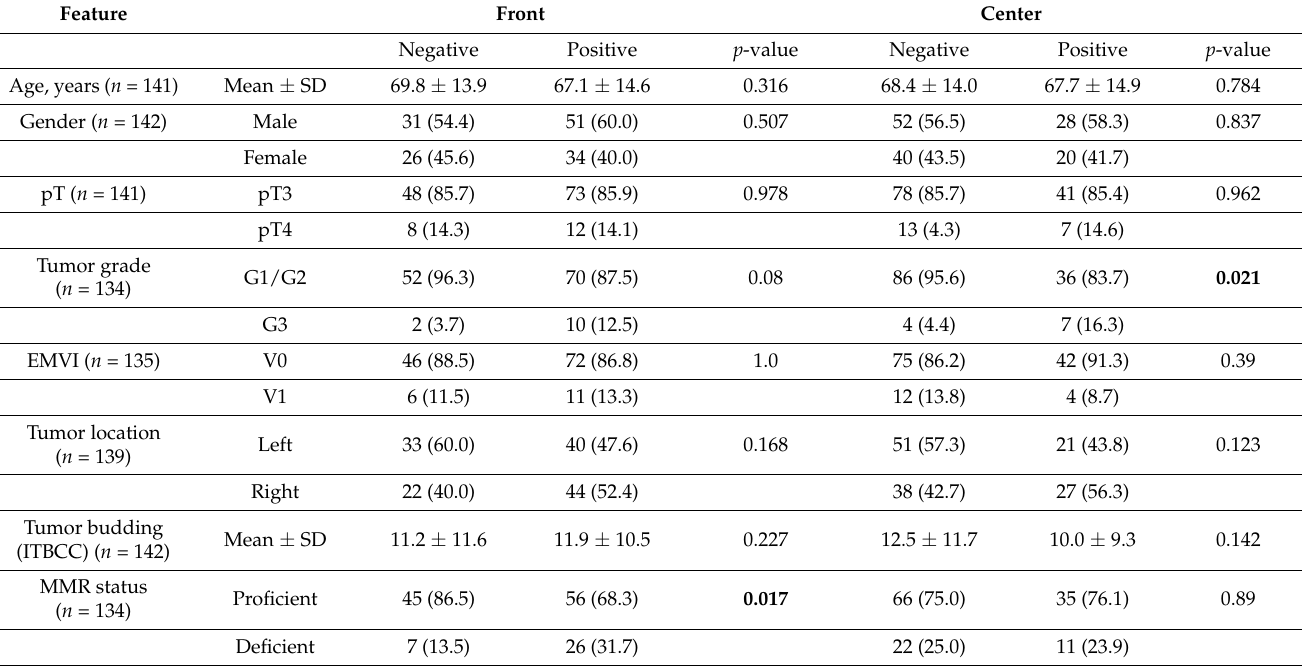
Table 2. Association of LAG-3 (front/tumor center) with clinicopathological features on the stage II colon cancer cohort. Feature